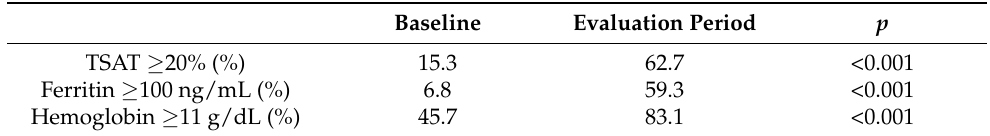
Table 3. Achievement of target for transferrin saturation (TSAT), ferritin and hemoglobin at baseline and in the evaluation period (week